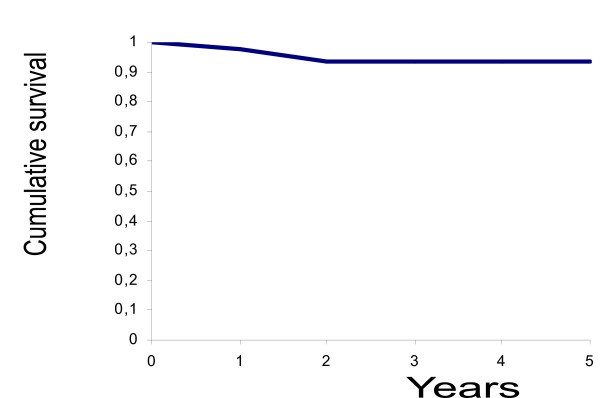
Actuarial five year survival rate. Actuarial five year survival rate was 93%. After a median follow-up of 55 months four recurrences and three deaths were observed, two for disease progression and one for heart failure.